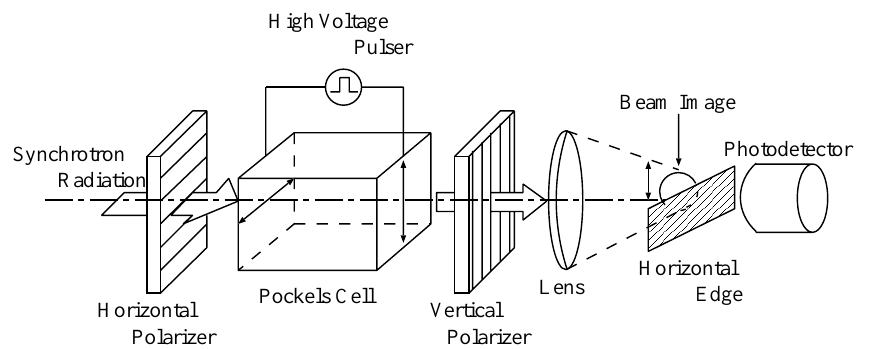
FIG. 1. Schematic diagram of the high-speed light shutter and the optical betatron oscillation detector.